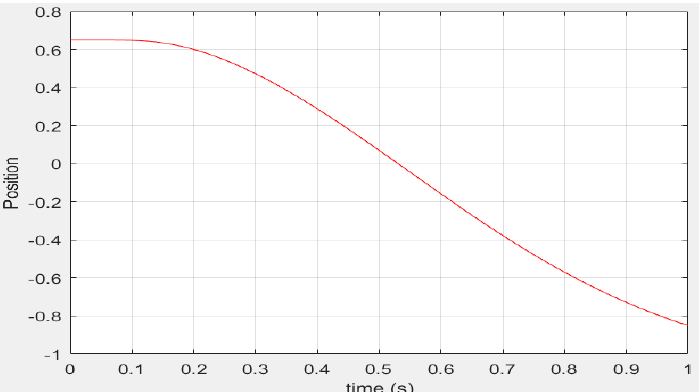
Figure 3. Representation of the second case. Example 3: Different shapes of trajectory have been presented at this moment, but this characteristic can increase if the parameter a is changed (see Figure 4). Moreover, the velocity, acceleration, and Jerk can increase and decrease in order to obtain linear or curved trajectories as well as diversity to generate trajectories.